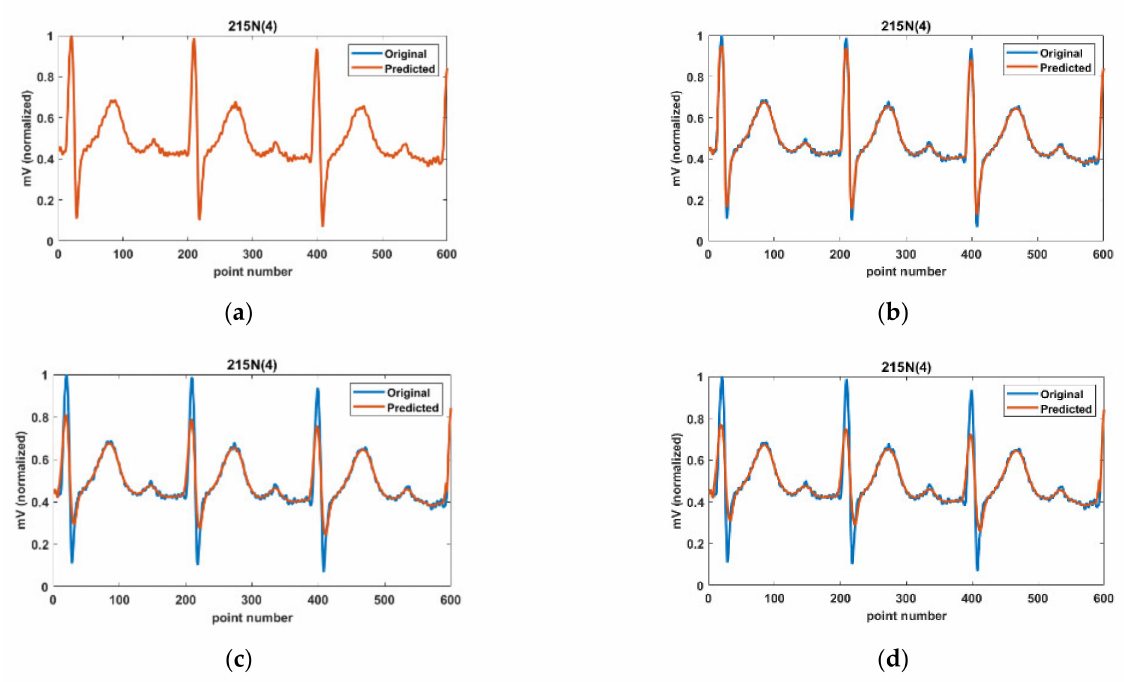
Figure 1. Impact of standard deviation; ( a ) σ d = 0.1, σ r = 0.1, ( b ) σ d = 5, σ r = 0.1, ( c ) σ d = 5, σ r = 1, and ( d ) σ d = 10, σ r = 1 in 215